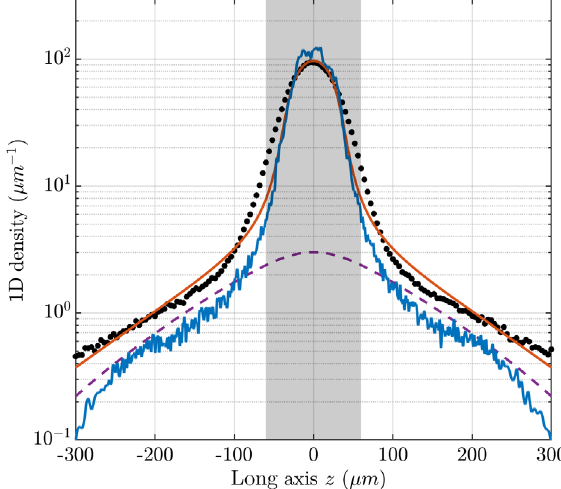
FIG. 8. Measured 1D density after 44 ms TOF for N ¼ 7450 ð 60 Þ atoms (black dots, average over ten repeats) compared to the simulated 1D density including phase and amplitude noise for N ¼ 7450 atoms and T ¼ 135 nK after 44 ms TOF, averaged over 100 repeats (blue line; see the text). The red line shows a bimodal fit to the data yielding a temperature of T ¼ 135 ð 10 Þ nK. The density of the condensed fraction is modeled with a Yang-Yang profile, the thermal fraction contain- ing approximately 10% of the atoms by a Bose function (dashed purple line) [67]. The gray shaded area depicts the plot range in Fig. 5 in the main